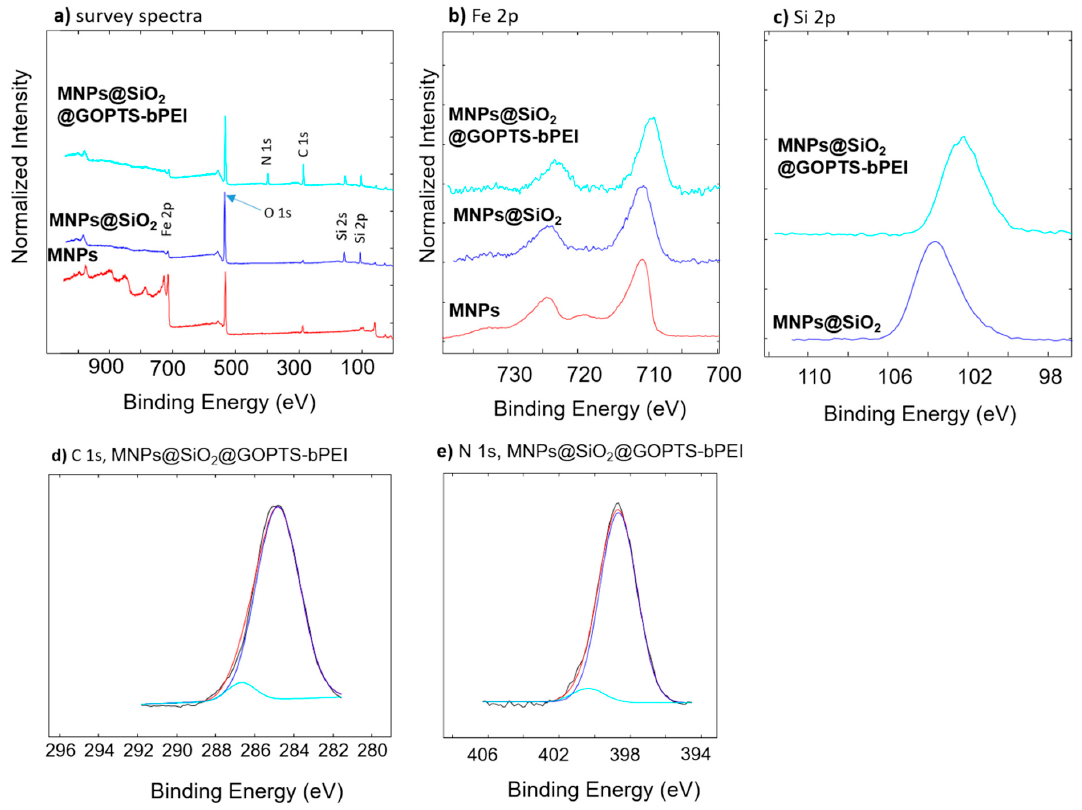
Figure 4. ( a ) Survey spectra and high-resolution, ( b ) Fe 2p and (c ) Si 2p spectra. Deconvoluted high-resolution, ( d ) C 1s spectrum for MNPs@SiO 2 @GOPTS-bPEI, and ( e ) N 1s